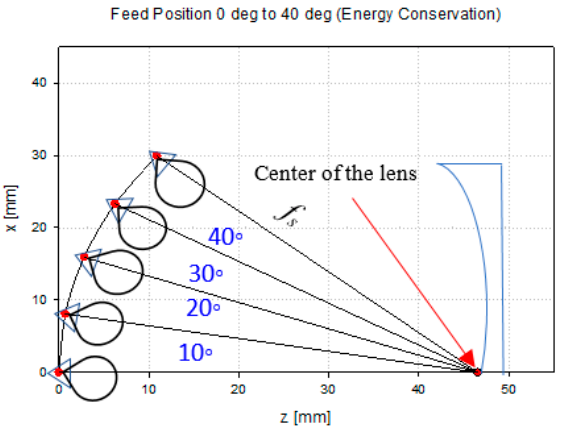
Figure 14. Feed position arrangement.